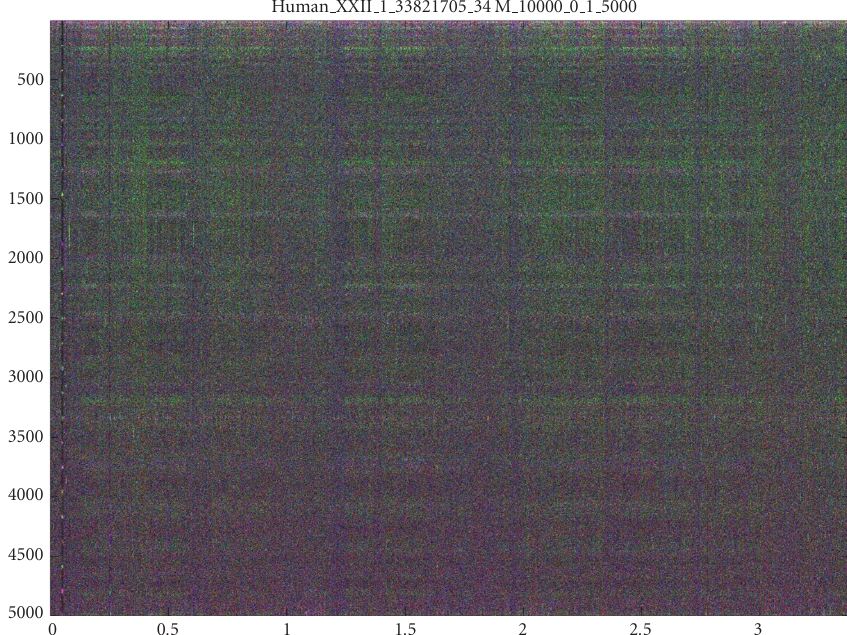
Figure 10: Spectrogram of human chromosome 22. Noticeably absent is the line representing the 3-base periodicity relating to protein coding. The 800 or so genes located on chromosome 22 simply do not cover enough of the chromosome to make a visible line at the resolution of 34 Mbp. Many periodicities are visible across the entire length of the